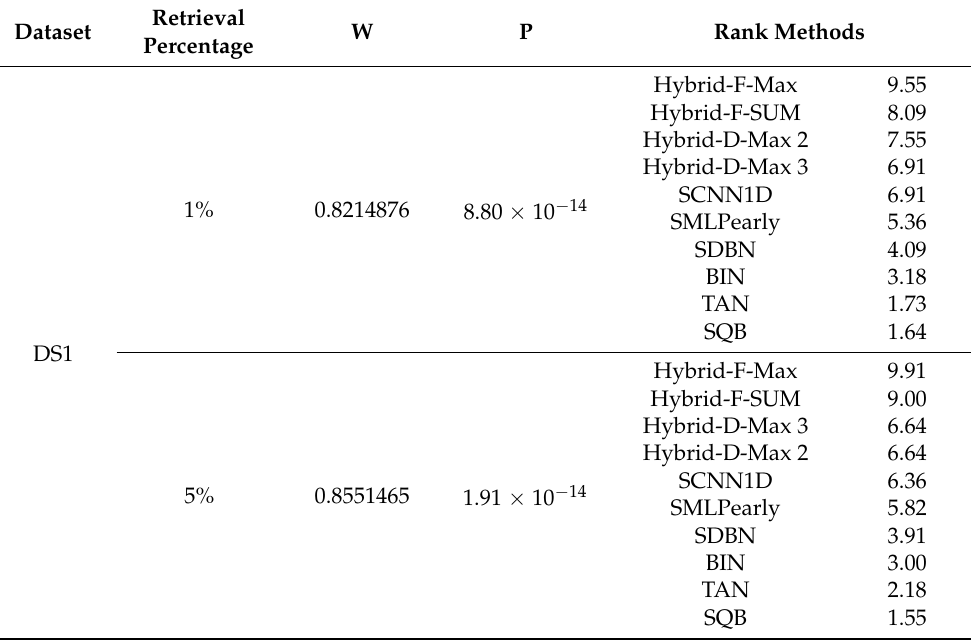
Table 13. Ranking of hybrid Siamese similarity models based on (TAN, BIN, SQB, SDBN, SCNN1D, and SMLP) using Kendall W test results for DS1, at top 1% and